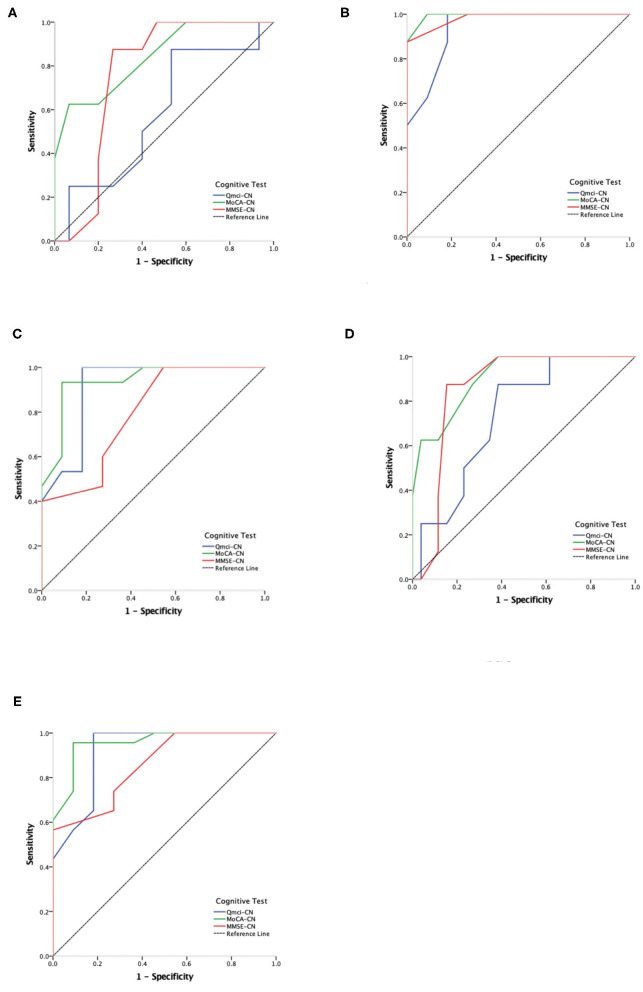
Receiver Operating Characteristic (ROC) curve analysis comparing the Chinese versions of the Quick Mild Cognitive Impairment (Qmci-CN) screen, Montreal Cognitive Assessment (MoCA-CN) and Mini Mental State Examination (MMSE-CN) in separating normal cognition (NC), post-stroke cognitive impairment no dementia (PSCIND) and post-stroke dementia (PSD). (A) NC vs. PSCIND; (B) NC vs. PSD; (C) PSCIND vs. PSD; (D) NC vs. PSCIND/PSD; (E) PSD vs. NC/PSCIND.